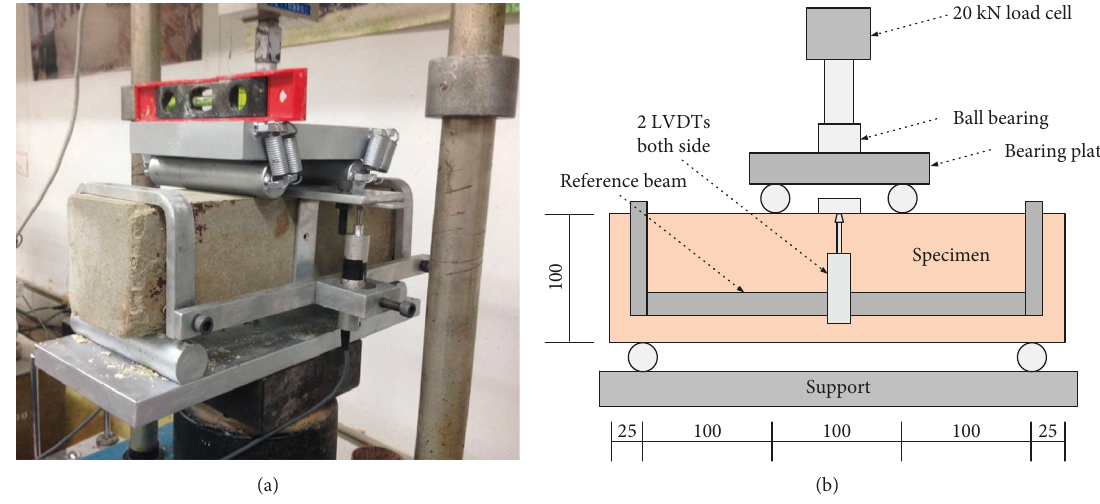
Figure 2: Photograph and schematic of the (a) experimental device and (b) specimen setup.